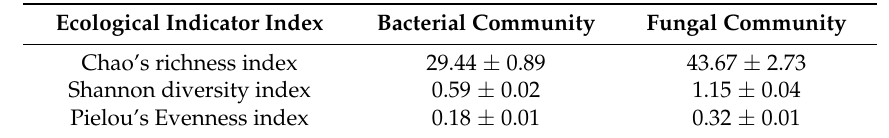
Table 2. Ecological indicator indices of bacterial and fungal communities in the orange juice processing waste examined.